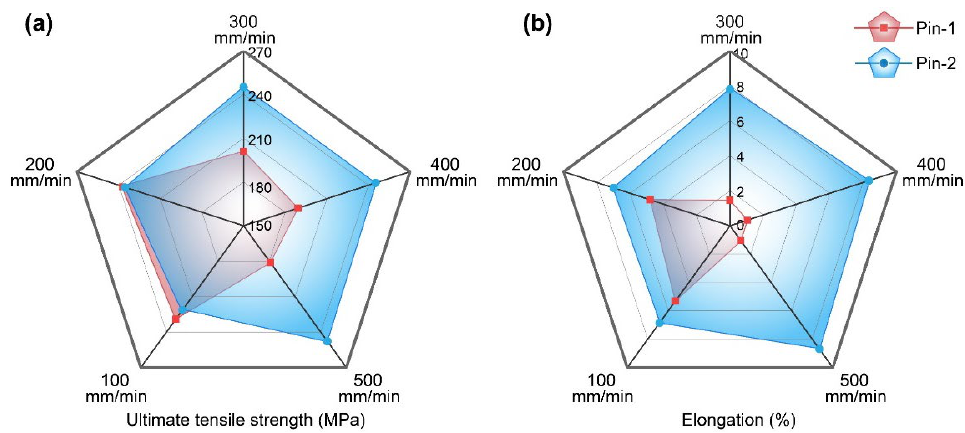
Figure 14. ( a ) Ultimate tensile strength and ( b )